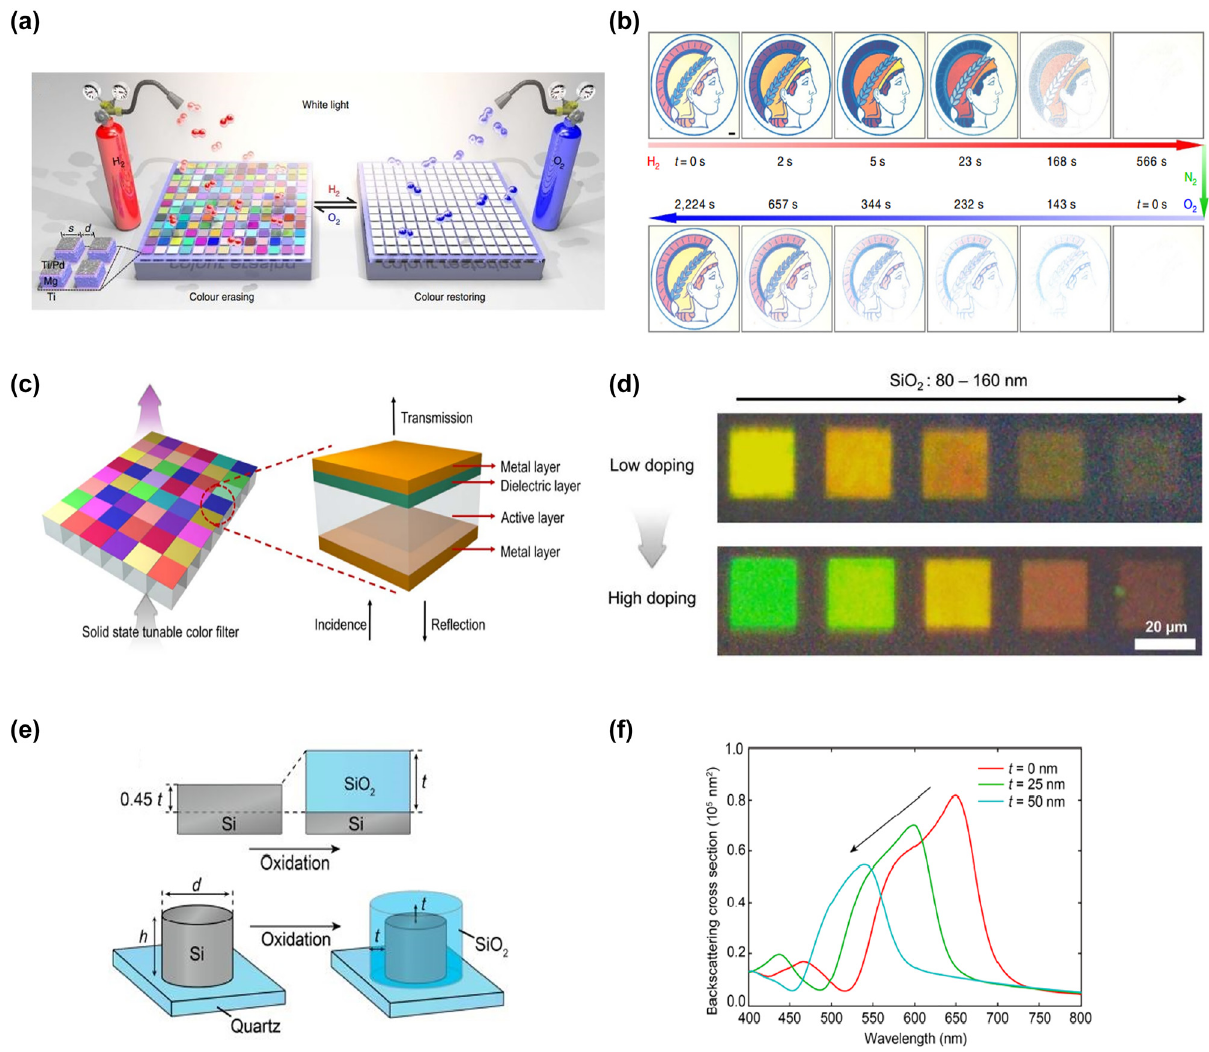
Figure 30: Dynamic structural color generation based on refractive index modulation through H hydrogen-responsive plasmonic metasurface, in which each dynamic plasmonic pixel is composed of Mg nanoparticles sandwiched between Ti/Pd capping layers and a Ti buffer layer. (b) Optical micrographs of the Minerva logo, showing the color erasing and restoring performance during